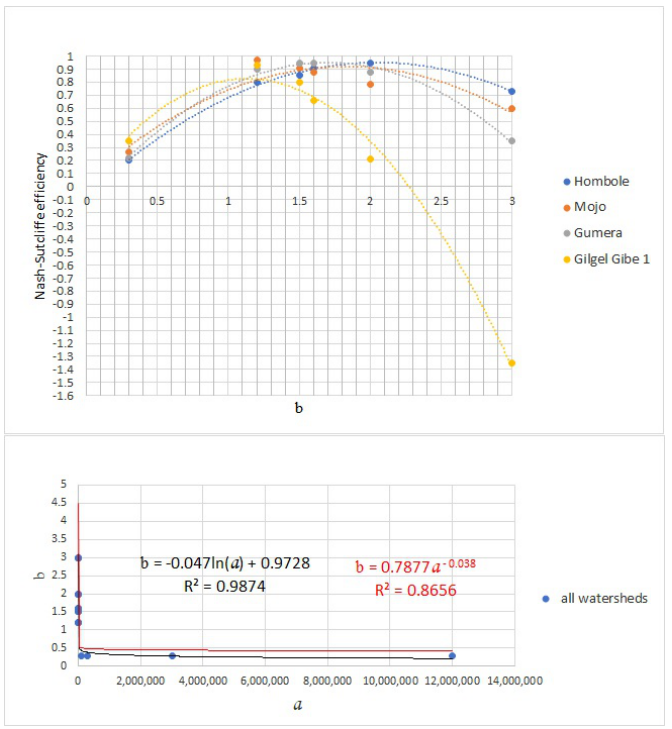
Figure 14. The relationship between exponent b versus the Nash–Sutcliffe efficiency and coefficient a versus exponent b when the topographic factor is calculated using Equations (27) and